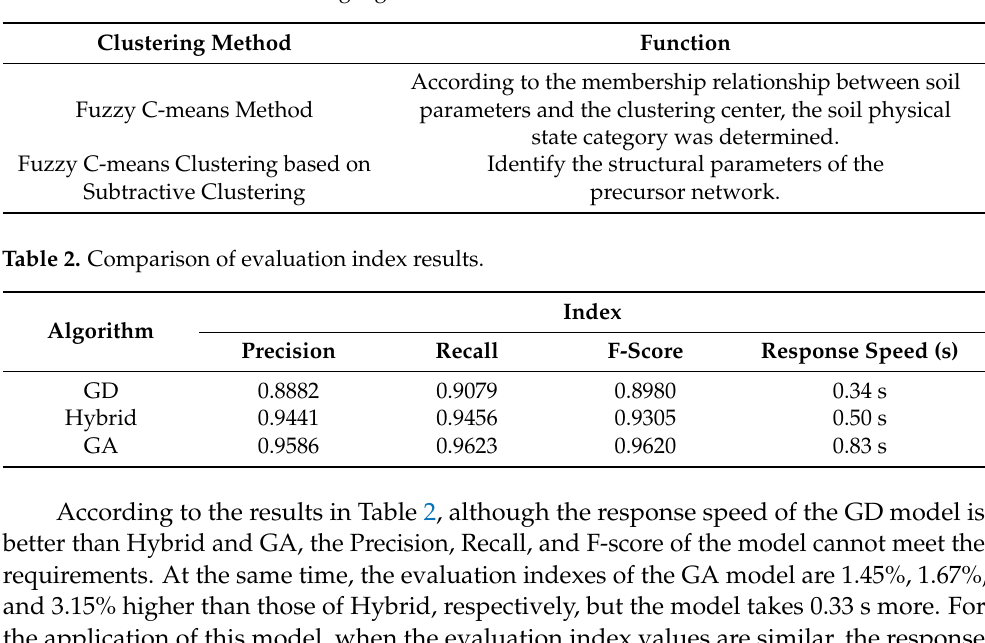
Table 1. Functions of the clustering algorithm.